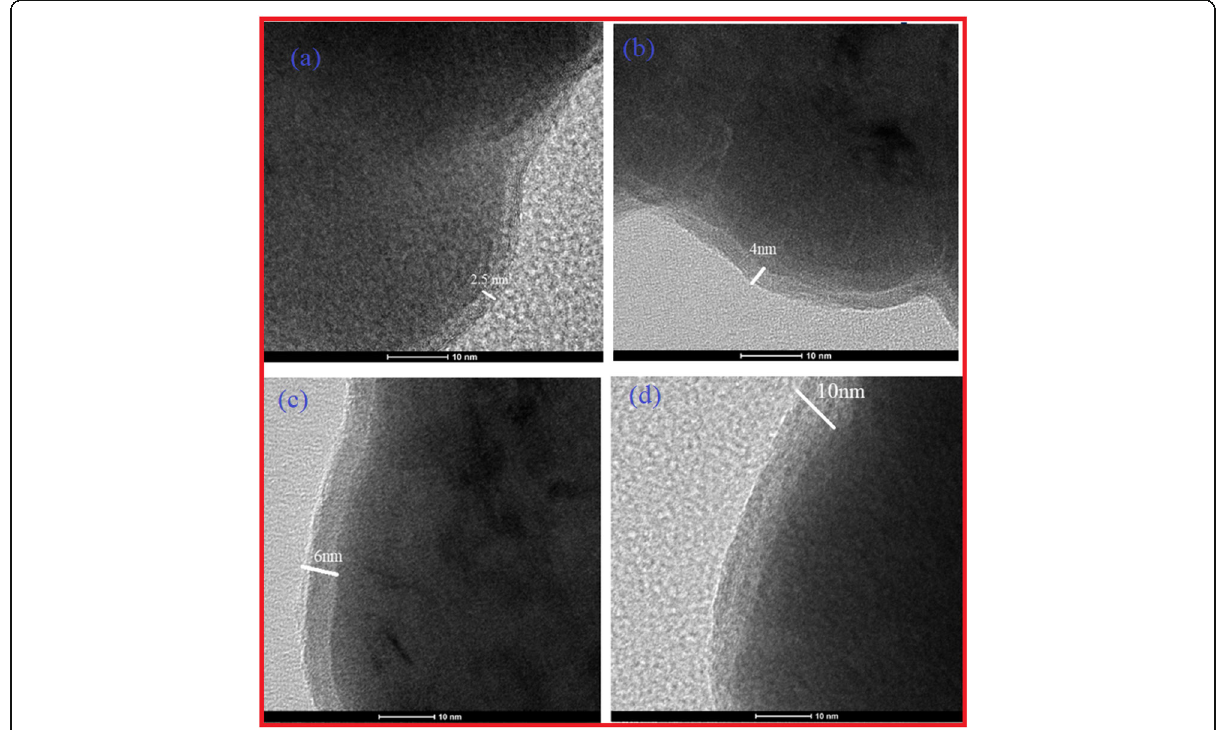
Fig. 5 TEM image of a Fe NCs-0, b Fe NCs-2, c Fe NCs-4, and d Fe NCs-(6) showing core-shell nature of Fe NCs with an increase in oxide thickness of 2.5 nm, 4 nm, 6 nm and 10